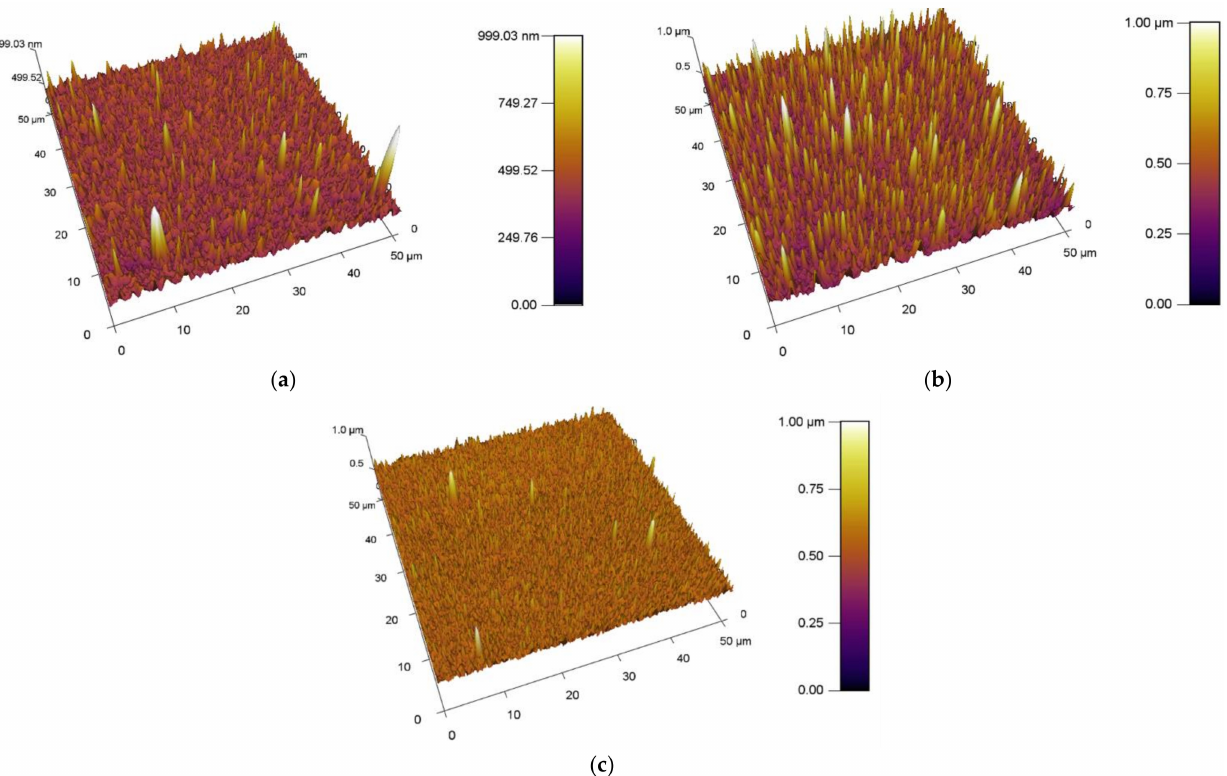
Figure 10. AFM images of plasma modified (modification type 2: INDIRECT MONO) surfaces of PVC. Exposure types I ( a ), II ( b ) and III ( c